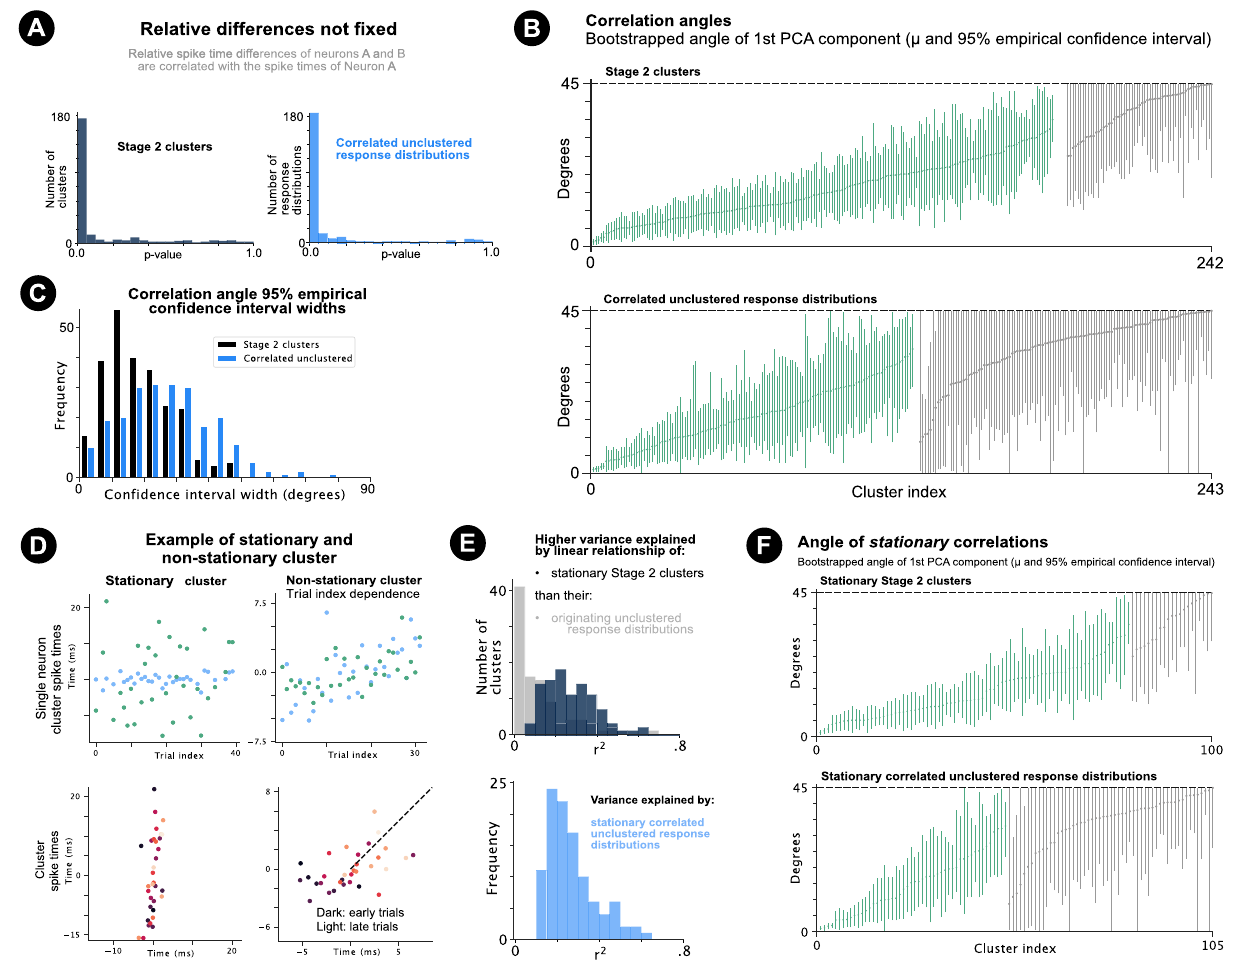
Figure 4. Correlation angles and stationary clusters. ( a ) Histograms of linear regression p -values of the first neuron’s spike time and the spike time difference. ( b ) Mean θ 45 angles with 95% empirical confidence intervals for positively correlated Stage 2 clusters (top) and unclustered response distributions (bottom). Green if ◦ ◦ significantly greater than 0 ( p -value < 0.025) and less than 45 ( p -value < 0.025). Grey otherwise. ( c ) Histogram of cluster angle 95% empirical confidence intervals. ( d ) Example of stationary (left) and non-stationary cluster (right) determined by the stationarity criteria (see Methods). Top row shows single neuron cluster spike times for each neuron (green and blue) plotted against cluster trial index. Bottom shows the cluster spike times of neuron A and B plotted against each other. Non-stationary cluster shows a clear trial dependence. ( e ) Top: Histogram of variance explained ( r 2 ) by the spike time linear relationship of each stationary Stage 2 cluster (dark blue) and the linear relationship of the unclustered response distributions from which stationary Stage 2 clusters were extracted (grey). Bottom: r 2 values shown for stationary unclustered response distributions ( f ) Predicted θ 45 angles with 95% empirical confidence intervals for stationary Stage 2 clusters (top) and stationary correlated ◦ ◦ unclustered response distributions. Angles significantly different from 0 ( p -value < 0.025) and 45 ( p -value < 0.025) coloured green. Grey